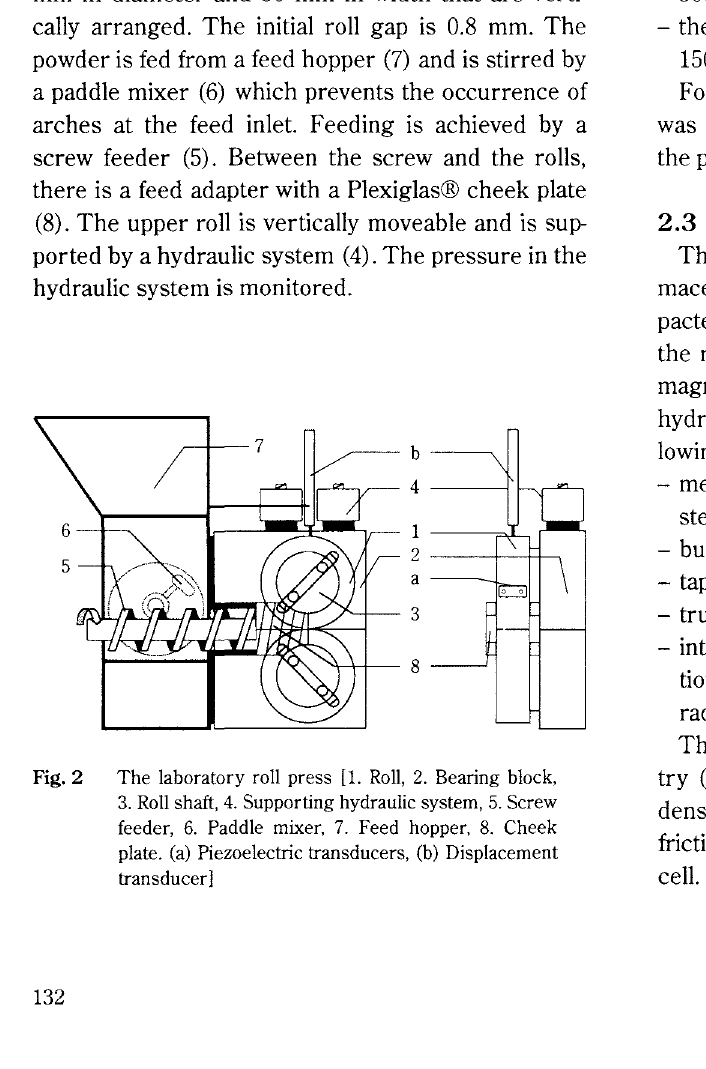
Fig. 2 The laboratory roll press [1. Roll, 2. Bearing block, 3. Roll shaft, 4. Supporting hydraulic system, 5. Screw feeder, 6. Paddle mixer, 7. Feed hopper, 8. Cheek plate. (a) Piezoelectric transducers, (b)